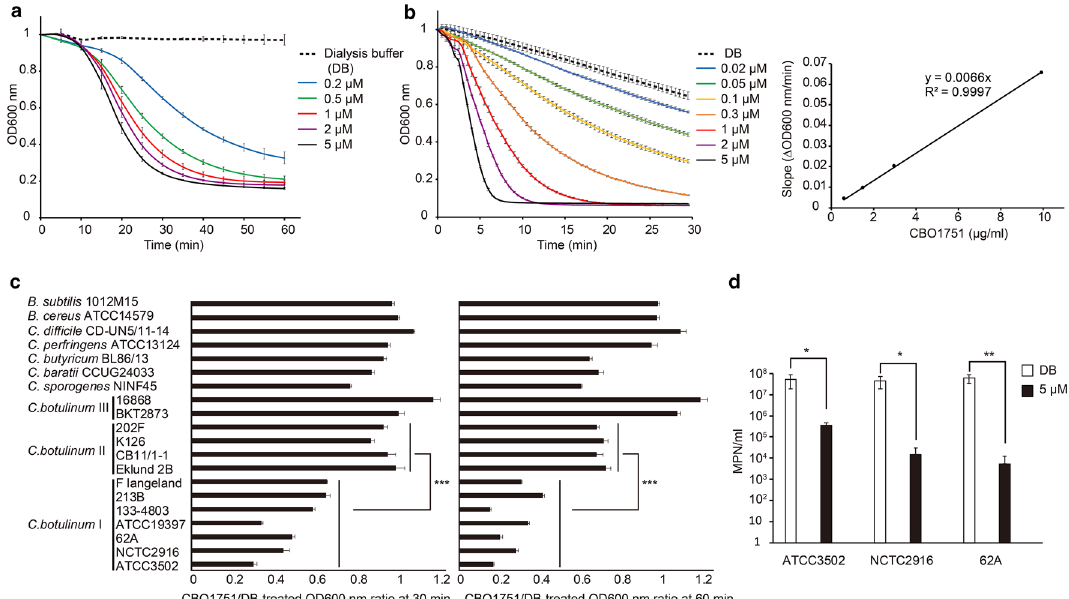
Figure 2. Lytic activity of CBO1751. ( a ) Lytic activity of CBO1751 as analyzed by measuring OD 600 of Clostridium botulinum ATCC3502 vegetative cell suspension over 60 min after addition of DB or 0.2 to 5 µM of CBO1751. ( b ) Determination of lytic activity of CBO1751. Left: Lytic activity analysis by measuring OD 600 of C. botulinum ATCC3502 frozen cell suspension over 30 min after addition of DB or 0.02 to 5 µM of CBO1751. Right: Linear regression plot of the slopes (ΔOD 600 /min) of lysis curves against the four CBO1751 concentrations (0.02, 0.05, 0.1 and 0.3 µM). All OD 600 values of ( a ) and ( b ) were normalized to an initial OD 600 of 1. ( c ) Lytic activity of CBO1751 against different Firmicutes strains as analyzed by comparing the ratio between OD 600 values of 5 µM CBO1751-treated against DB-treated vegetative cell suspensions for 30 and 60 min. ( d ) Most probable number (MPN) enumeration of C. botulinum ATCC3502, NCTC2916 and 62A cells after treatment with 5 µM of CBO1751 or DB for 60 min. All results are presented as means of three replicates ± standard deviations. *, P < 0.05; **, P < 0.01; ***, P <